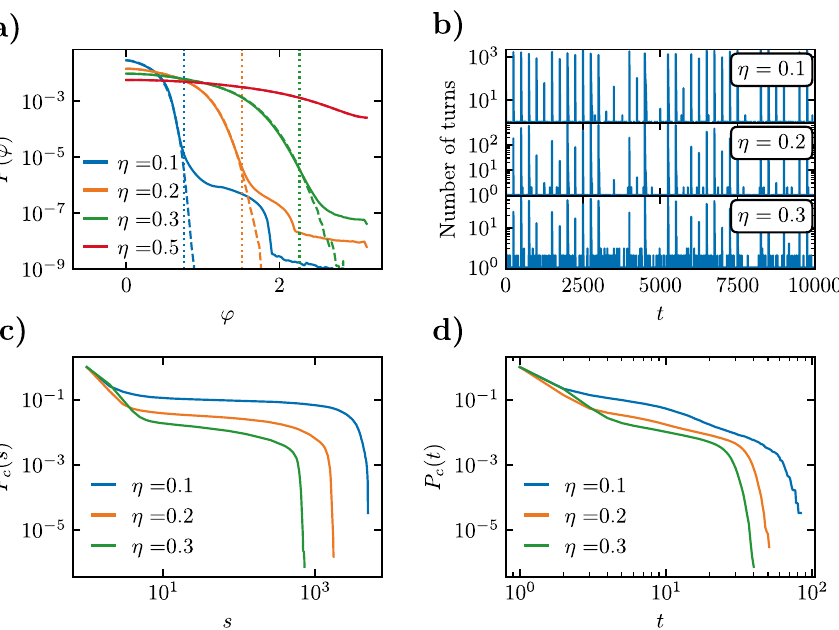
Figure 4. ( a ) Probability density of the turning angles ϕ for the Vicsek model with a leader, for different values of the noise intensity η , in a system of size L = 220 . Dashed lines correspond to a non-turning leader. Full lines represent a leader perturbed periodically every 250 time steps. Vertical lines, indicating the departure of the distributions for perturbed and non-perturbed leaders, are estimated at a value ϕ c (η) ≃ 2.4 πη . ( b ) Number of SPPs turning an angle larger than ϕ th (η) = 2.5 πη in a sequence of 10,000 simulation time steps in the Vicsek model with a periodically perturbed leader, for different values of η . ( c ) Cumulated distribution of sizes P c ( s ) of avalanches induced by a periodically perturbed leader in a system of size L = 220 with turning threshold ϕ th (η) , for different values of the noise intensity. ( d ) Cumulated distribution of durations P c ( t ) of avalanches induced by a periodically perturbed leader for different values of the noise